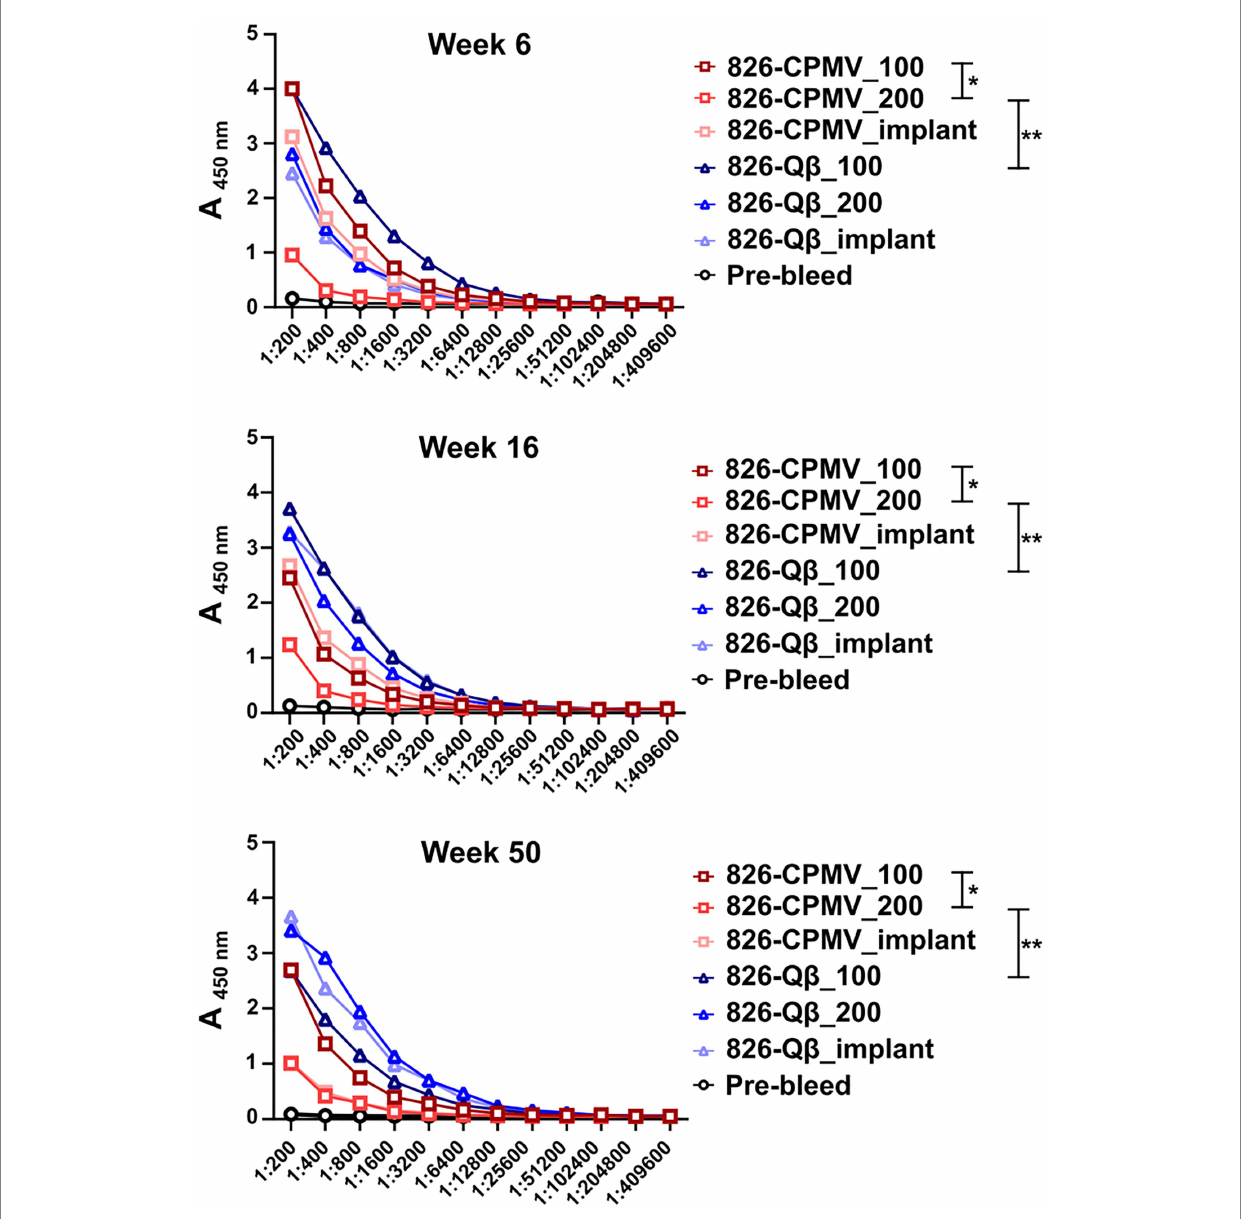
FIGURE 3 Antibody response of CPMV/Q β vaccine candidates after s.c. administration. Mice received (Lai et al., 2020) two doses of 100 μ g particles (826- CPMV_100 or 826-Q β _100), (Jalkanen et al., 2021) one dose of 200 μ g particles (826-CPMV_200 or 826-Q β _200), or (Nagpal et al., 2022) the slow- release implant (826-CPMV_implant or 826-Q β _implant). Antibody titers against the 826 epitope were measured by ELISA during the post- immunization period for 50 weeks. Two-way ANOVA using pairwise multiple comparison followed by Tukey’s multiple comparison test was used to compare between groups. Asterisks in the Support Information Supplementary Table S1 indicate significant differences between groups (* p < 0.05; ** p < 0.01, **** p <